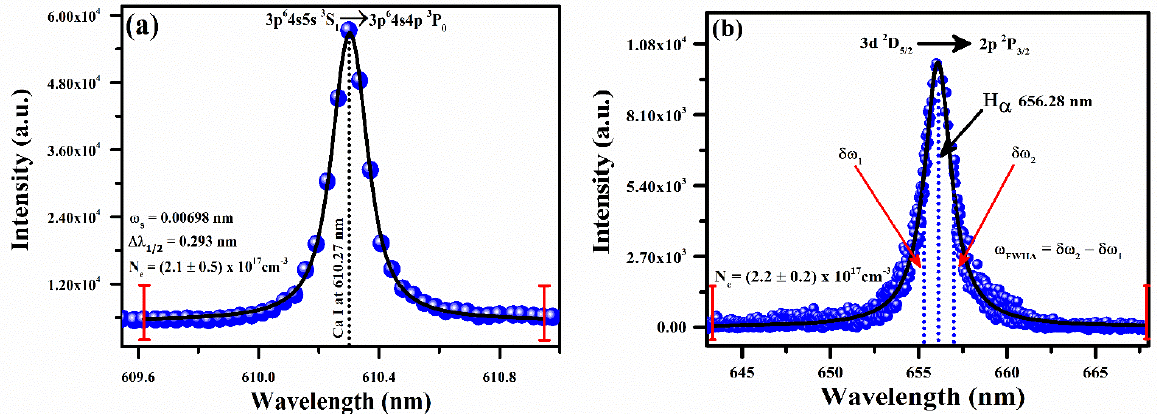
Figure 5. ( a ) Stark-broadened line profile of Ca I spectral line at wavelength 610.27 nm; ( b ) H α spectral line of hydrogen at wavelength 656.28 nm, showing full width at half area ( FWHA ). The full width at half area ( FWHA ) is calculated using a H α of a hydrogen emission spectral line at wavelength 656.28 nm, as demonstrated in Figure 5b. The observed line profile (red color) data and two dotted vertical lines correspond to FWHA yielding as (0.94 ± 0.05) nm. The simplest formula for the calculation of plasma electron density using H α line is given as follows [42,43]: ω 𝐹𝐹𝐹𝐹𝐹𝐹𝐹𝐹 = 5.49Å × (